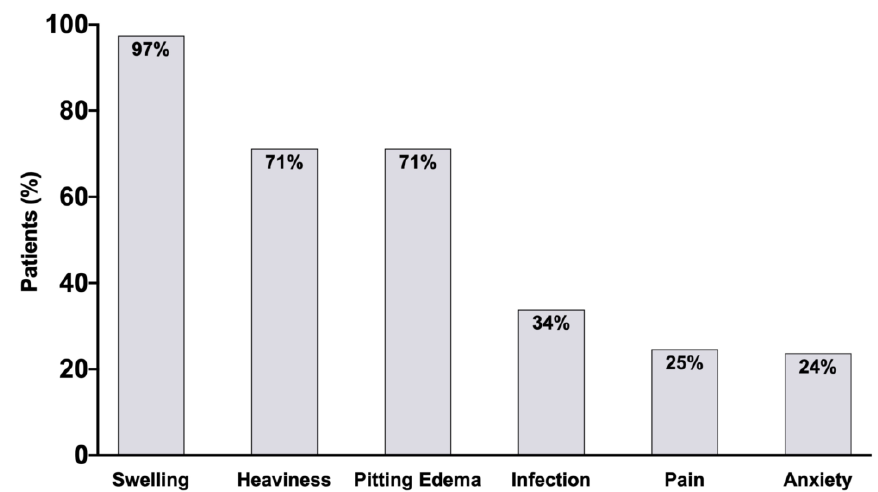
Figure 1. Extremity lymphedema presenting signs and symptoms.